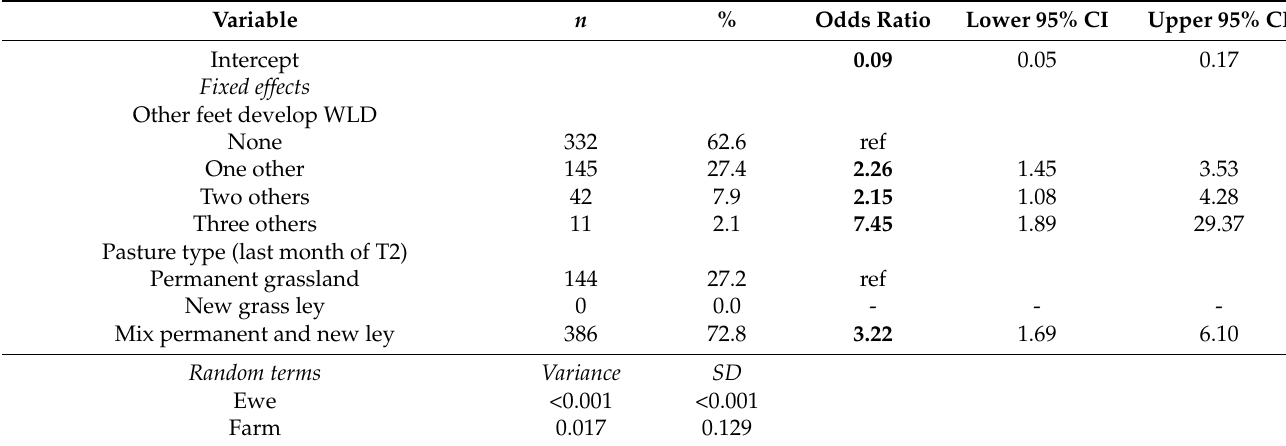
Table 13. Final multivariable model of the associations with the development of WLD at foot-level for 530 observations of